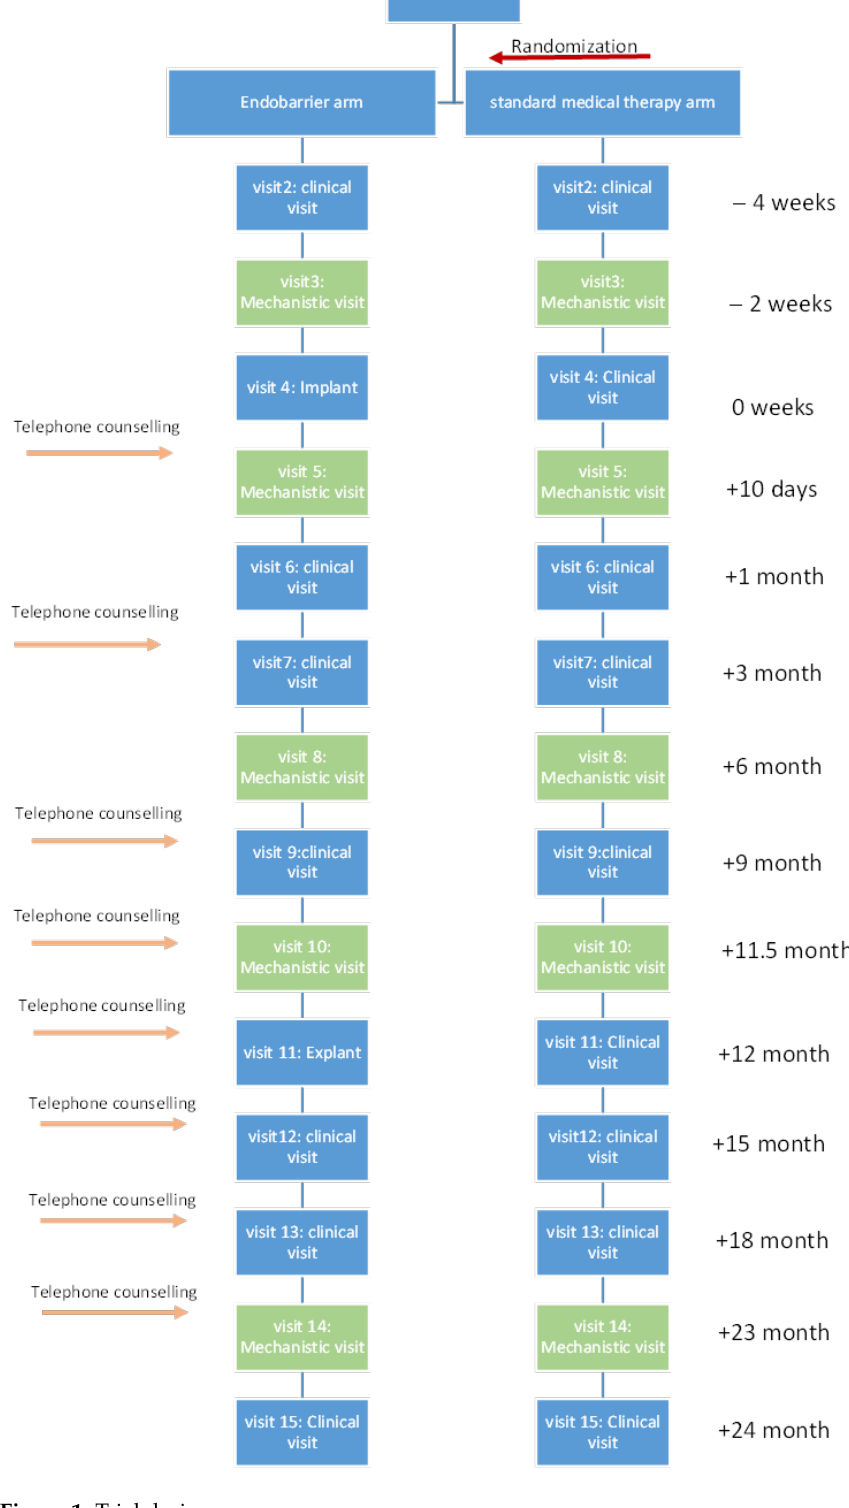
Figure 1. Trial Figure 1. Trial design.